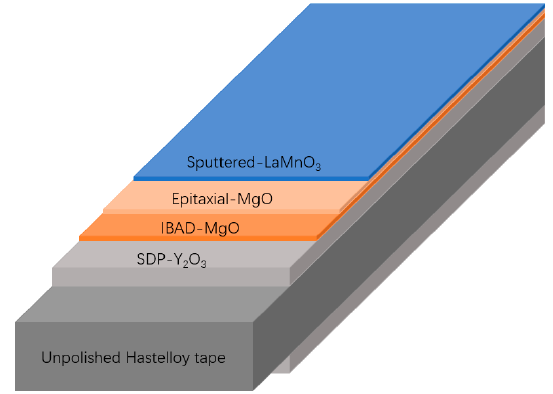
Figure 3. The schematic diagram of the buffer layers on the Hastelloy tape.